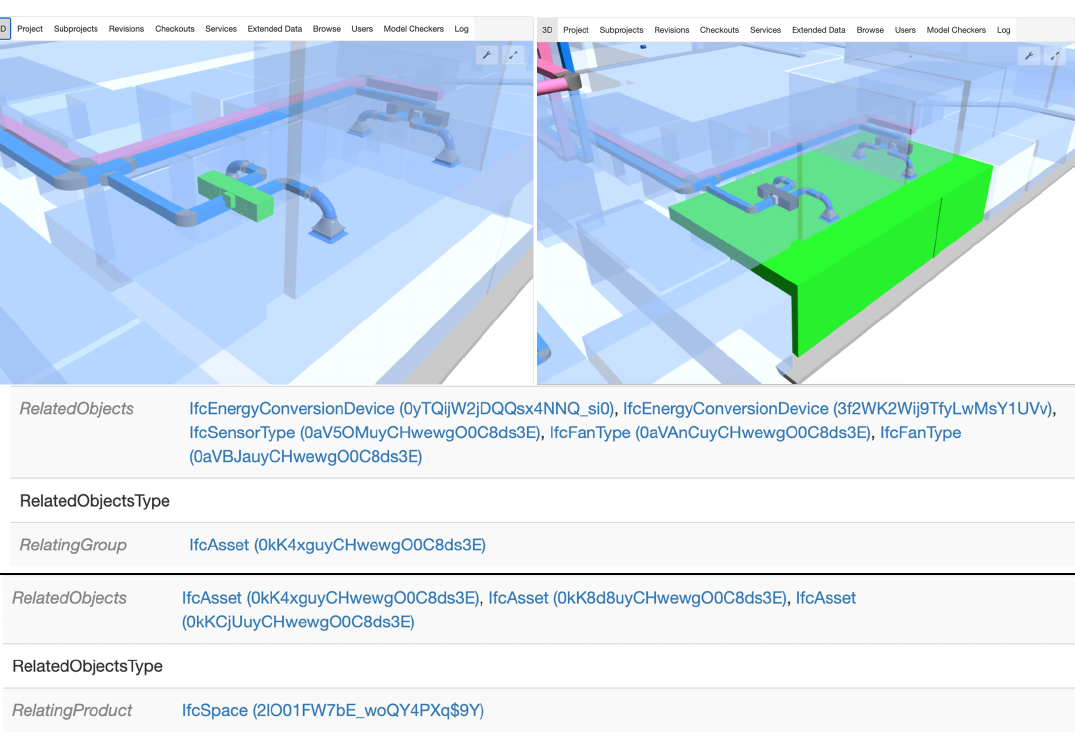
Figure 4. Visualisation of processed IFC through